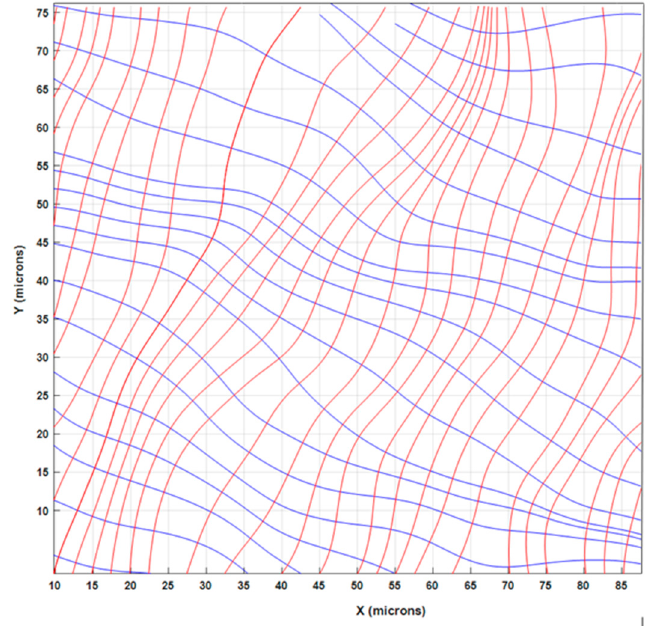
Figure 14. Al–SiC composite specimen: ( a ) Principal strain ε p1 ; ( b ) Principal strain ε p2 ; ( c ) Angle defining the direction of principal strains θ p .